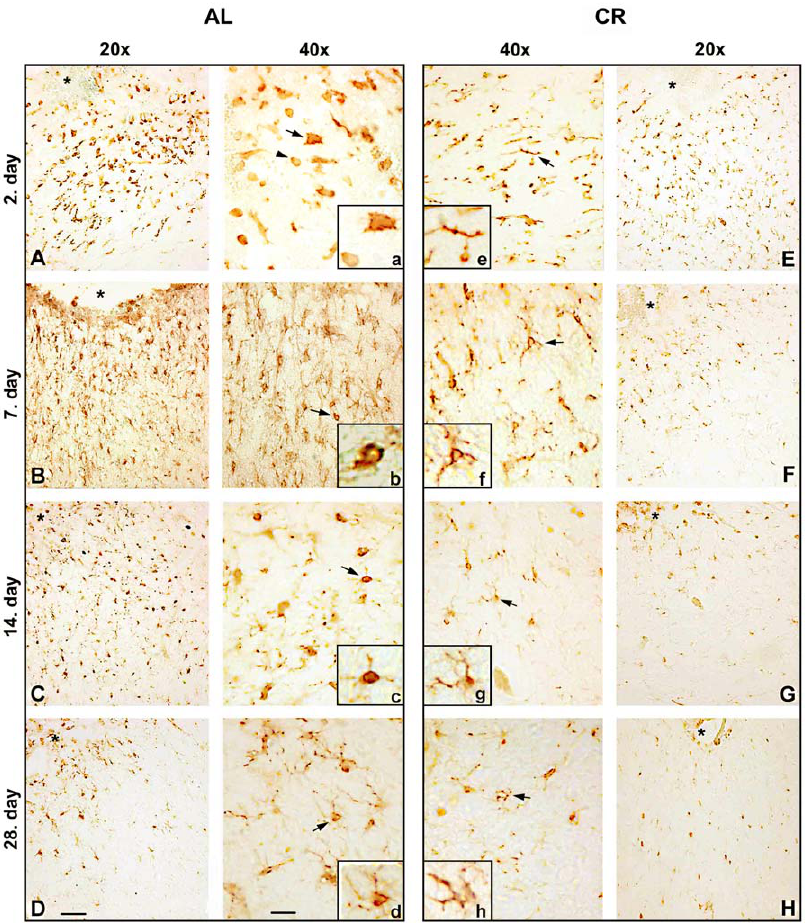
Figure 1. CR suppresses activation of microglia in the perilesioned area when applied prior to cortical stab injury. Brain sections from AL and CR animals 2, 7, 14, 28 days after injury were stained for the Iba-1 marker of microglial cells. Activated microglial cells displaying highly amoeboid and round-shaped morphology (Fig. 1a) were observed only in the AL group on the 2 nd day following injury (Fig. 1A). A number of moderately activated microglial cells (Fig. 1b, c) were observed in AL animals on the 7 th and 14 th day following injury (Fig. 1B, C). In the CR group microglial cells retained a mainly ramified structure throughout the recovery period (Fig. 1 E–H). Images are representative of 3 animals per experimental group; asterisk – site of the lesion. Scale bars: 50 m m and 25 m m for 20 6 and 40 6 magnification,